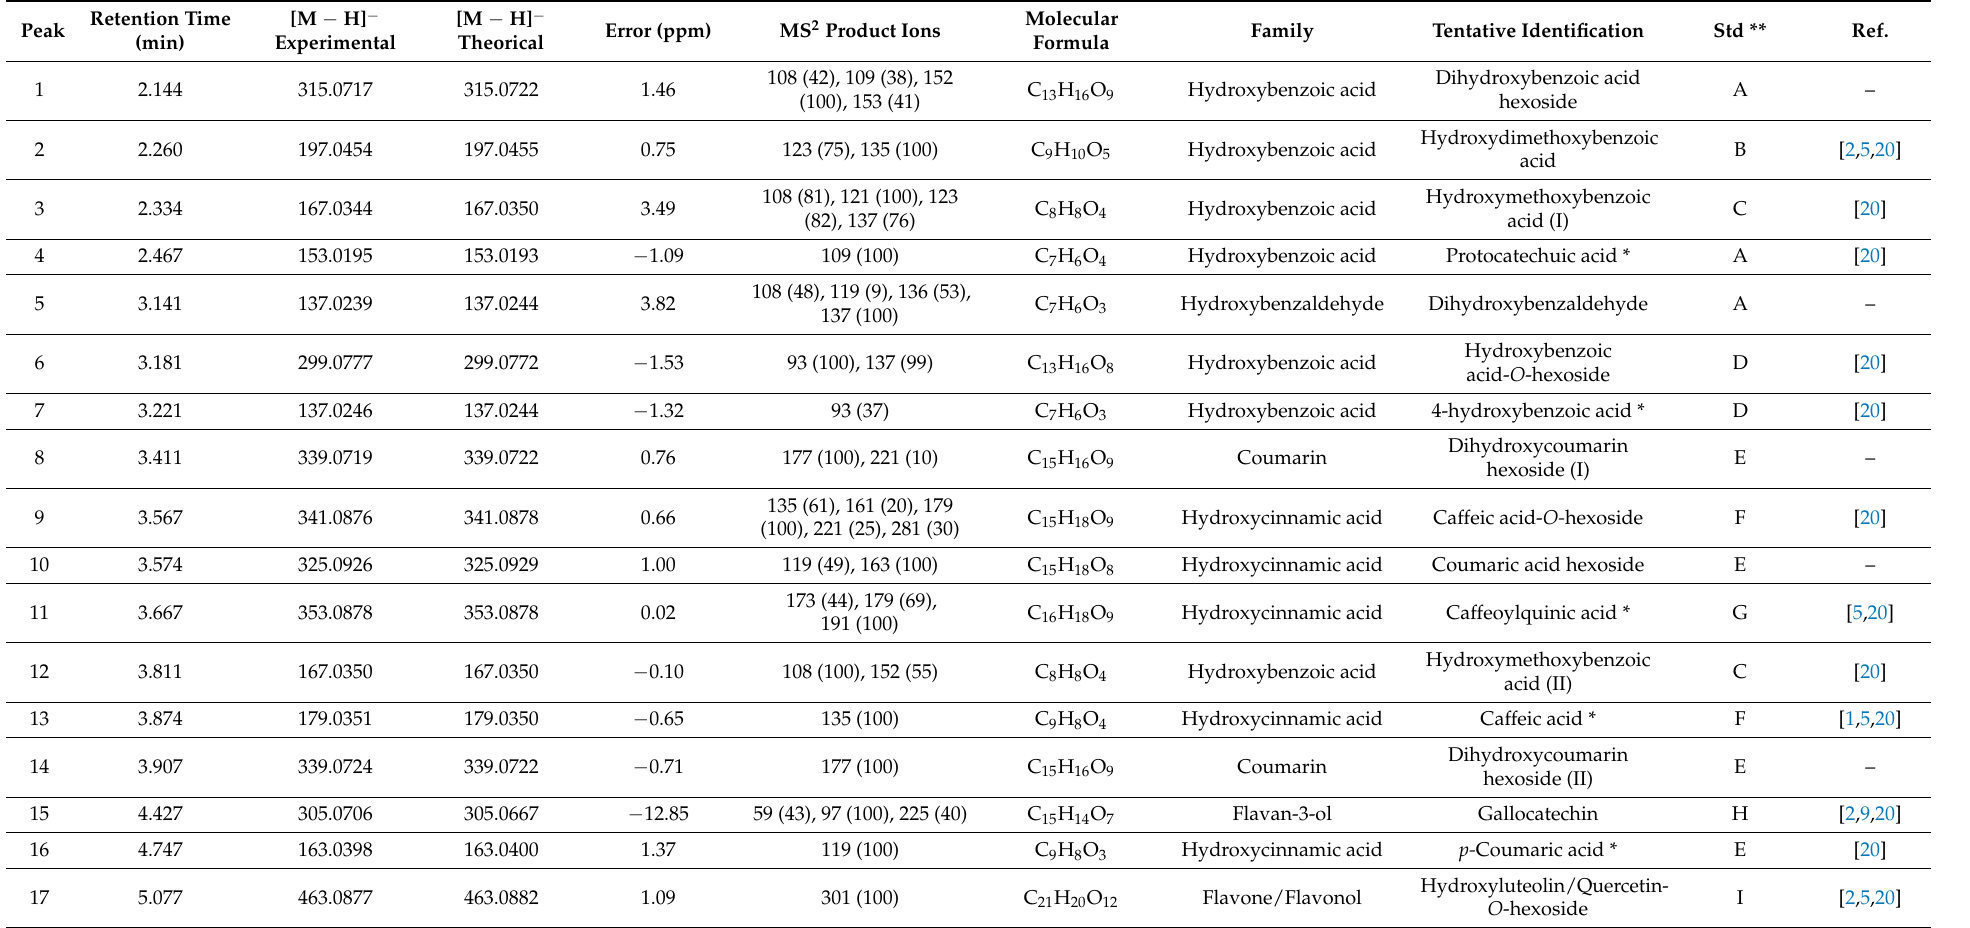
Table 3. Tentative identification of compounds detected in rosemary infusions by